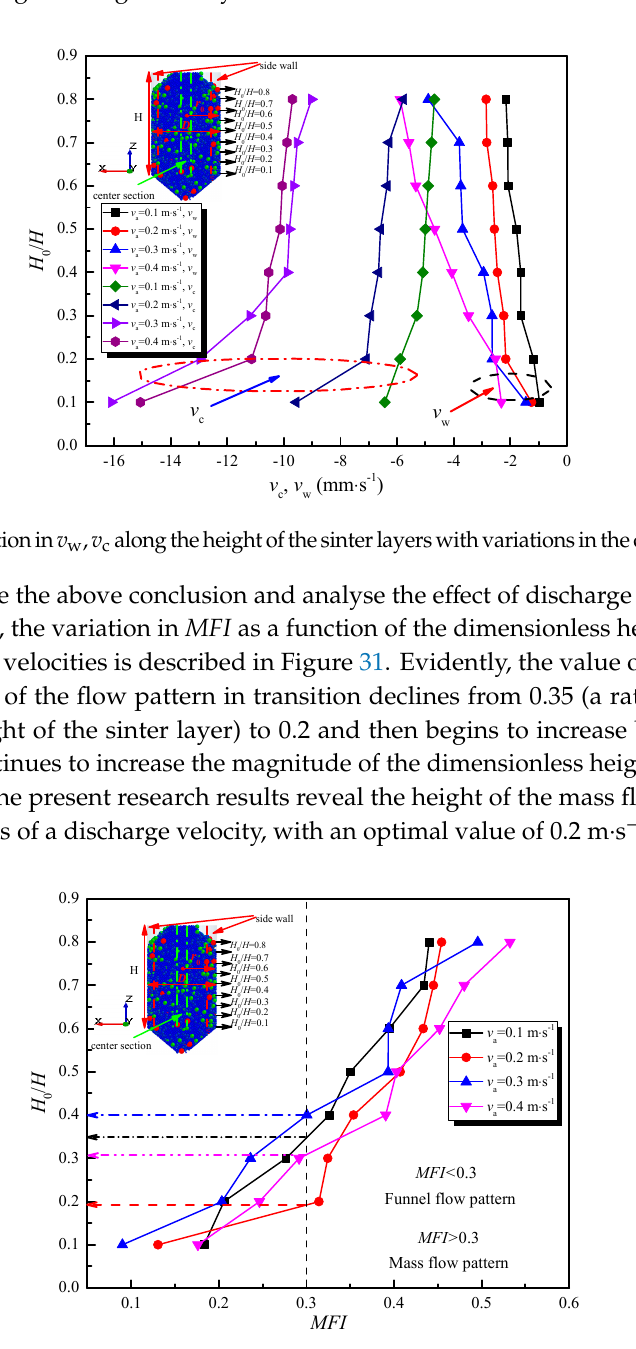
Figure 31. The variation in MFI along the height of the sinter layers with variations in the discharge velocity.